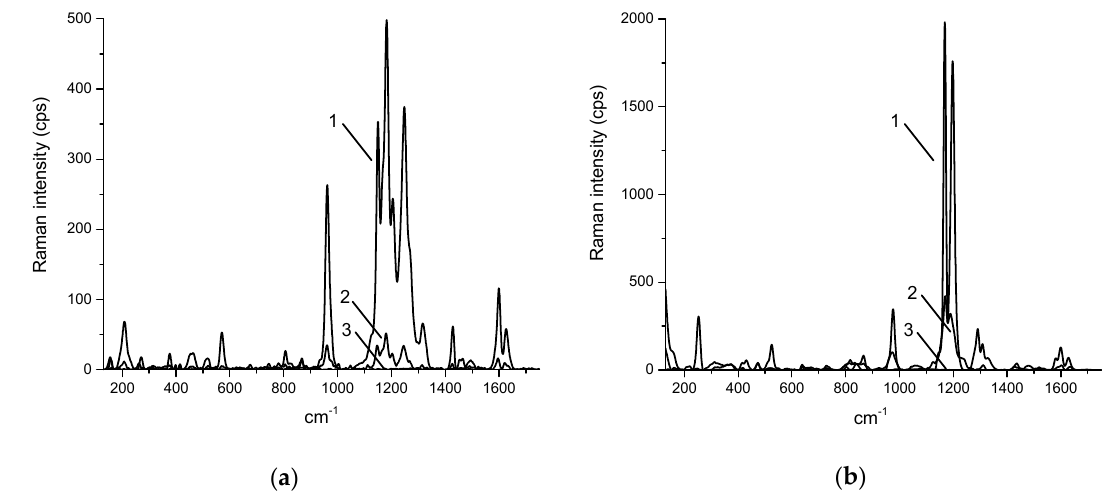
Figure 3. Typical Raman spectra of cream ( a ) and gel ( b ) containing curcumin, where 1—Raman spectrum of aggregated curcumin, 2—Raman spectrum of curcumin, dissolved in the base, and 3—Raman spectrum of the base without curcumin.